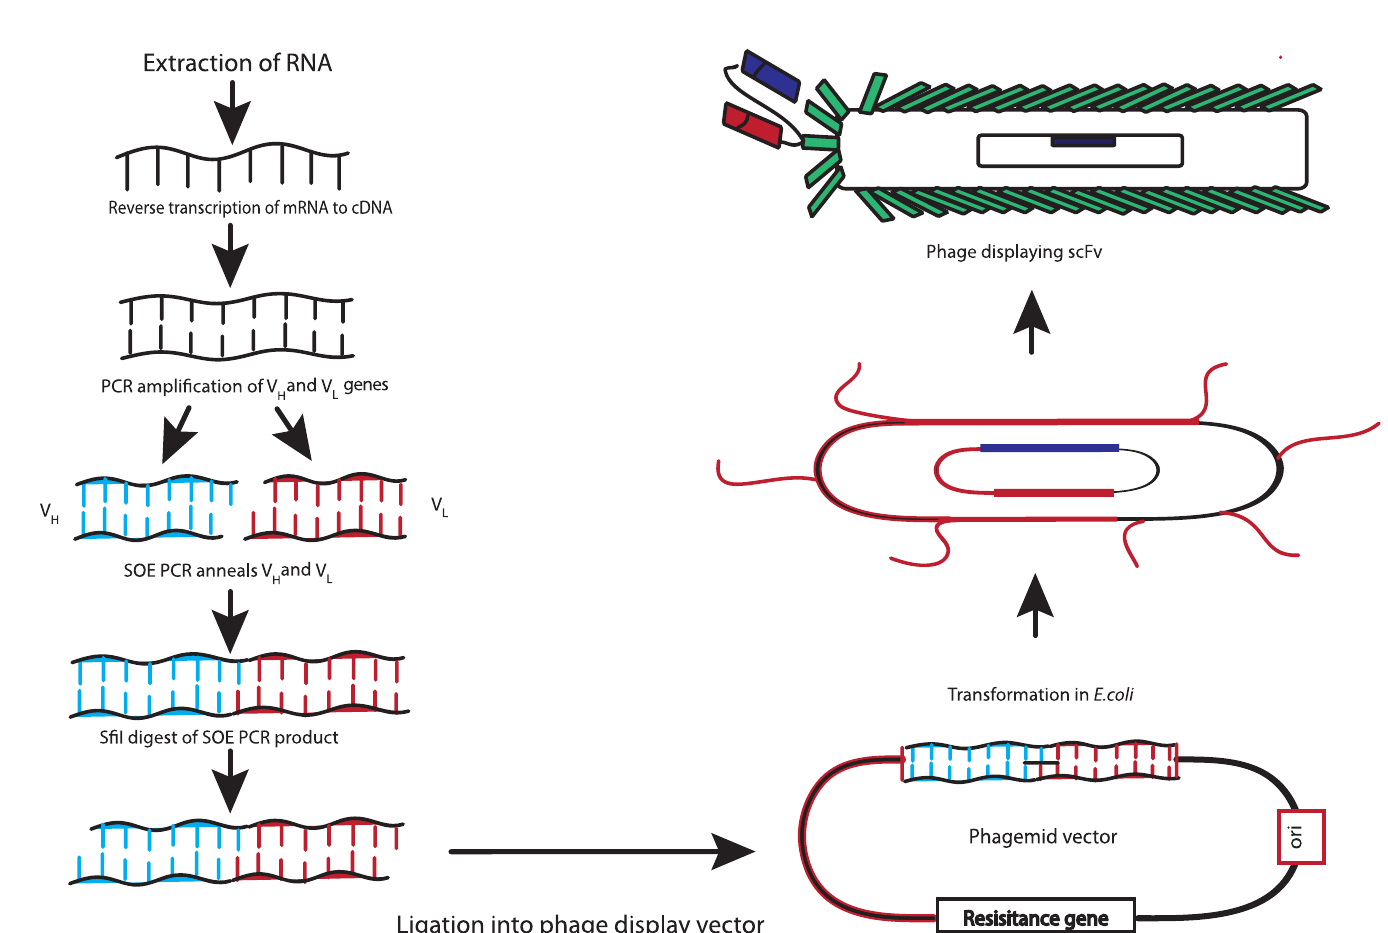
Fig 6. Strategy for cloning the variable light and heavy chains from the NCD1.2 hybridoma cell to create a NCD1.2 scFv-phage display library. RNA is extracted from hybridoma cell lines, followed by cDNA production. The cDNA was used as a template for the PCR-amplification of heavy and light chain variable regions using a diverse template primer set in order to capture the expressed sequences. The purified light and heavy chains were spliced together using PCR to create a 800 bp overlap product. This product was digested with SfiI , ligated into pCOMB3xSS, and transformed into TG1 cells. These cells are then be used to propagate the scFv-phage library for isolation of bioactive scFv-gIII fusion